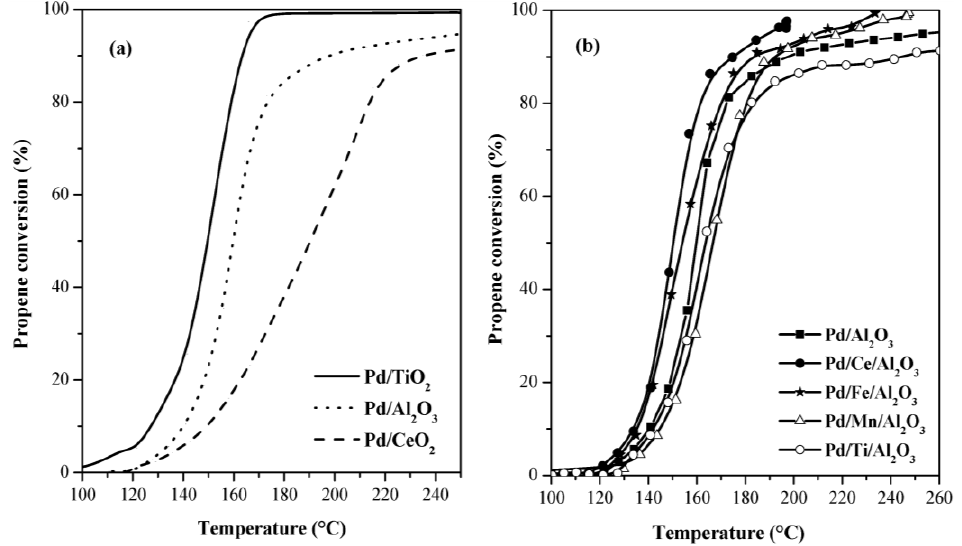
Figure 9. C 3 H 6 conversion (%) versus temperature (light-off curve) of ( a ) Pd-supported catalysts and ( b ) Pd-doped-supported catalysts, during the cooling ramp.